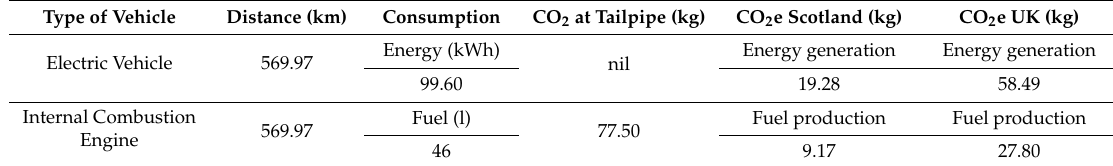
Table 10. Electric vehicle vs. internal combustion engine.